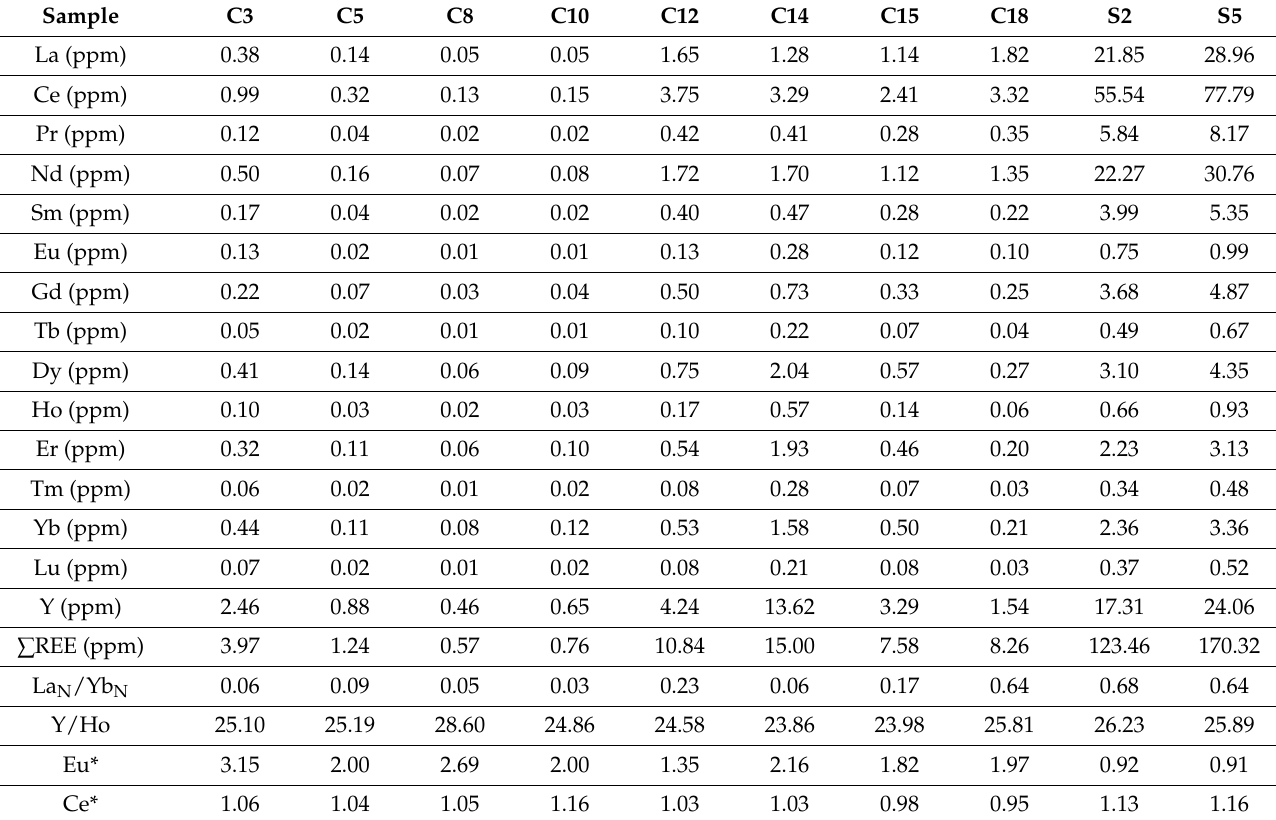
Table 2. Rare earth elements (ppm) and yttrium (ppm) of chert nodules and surrounding rocks in the Lucaogou Formation, Junggar